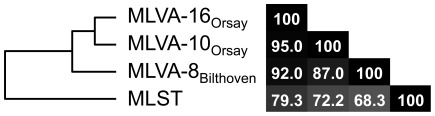
Congruence of MLVA and MLST.Congruence of MLVA schemes (MLVA-16Orsay, MLVA-10Orsay, and MLVA-8Bilthoven) and MLST using a Pearson correlation coefficient.